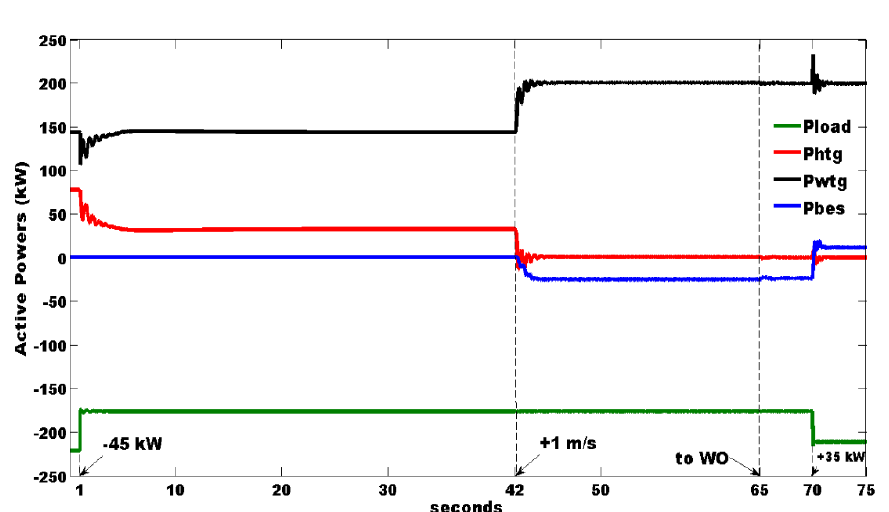
Figure 7. Voltage per unit (RMS).